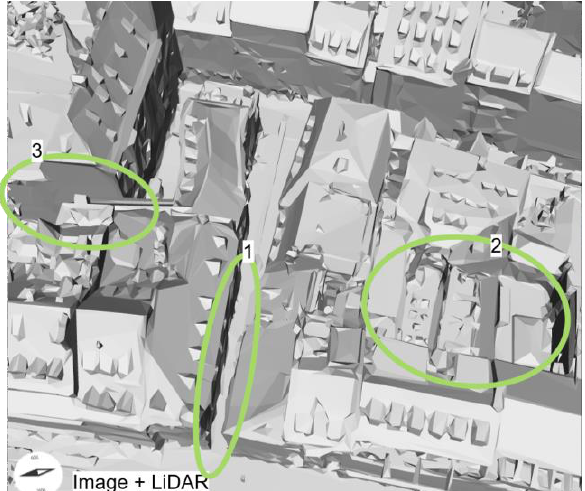
Figure 12: Comparison of 3D Mesh from image only (top) and image + LiDAR (below) approach. 3D mesh generated by